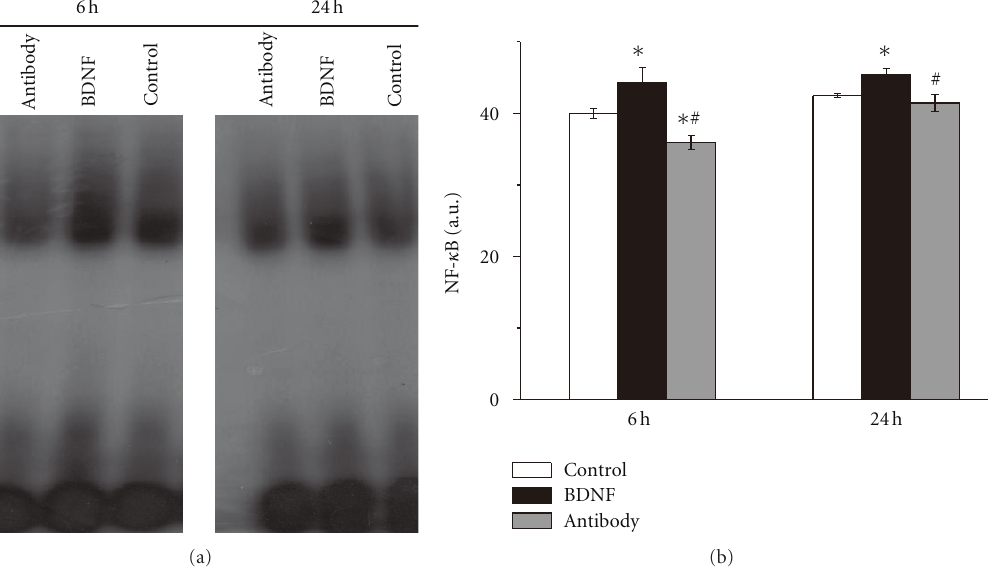
Figure 7: BDNF enhancing DNA-binding activity of NF- κ B The DNA-binding activity of NF- κ B in ischemic cortex in three groups was measured using Electrophoretic mobility shift assay (EMSA) 6h and 24 h after reperfusion. Levels of NF κ B DNA binding activity were expressed as arbitrary densitometric units (AU.) using Image J. Exogenous BDNF increased the activity of NF- κ B 6h and 24h after reperfusion. Inhibition of endogenous BDNF by its antibody significantly decreased the activity 6h after reperfusion. Bars represent mean ± SD ( n = 6). ∗ P < . 05 versus control group, # P < . 05 versus BDNF